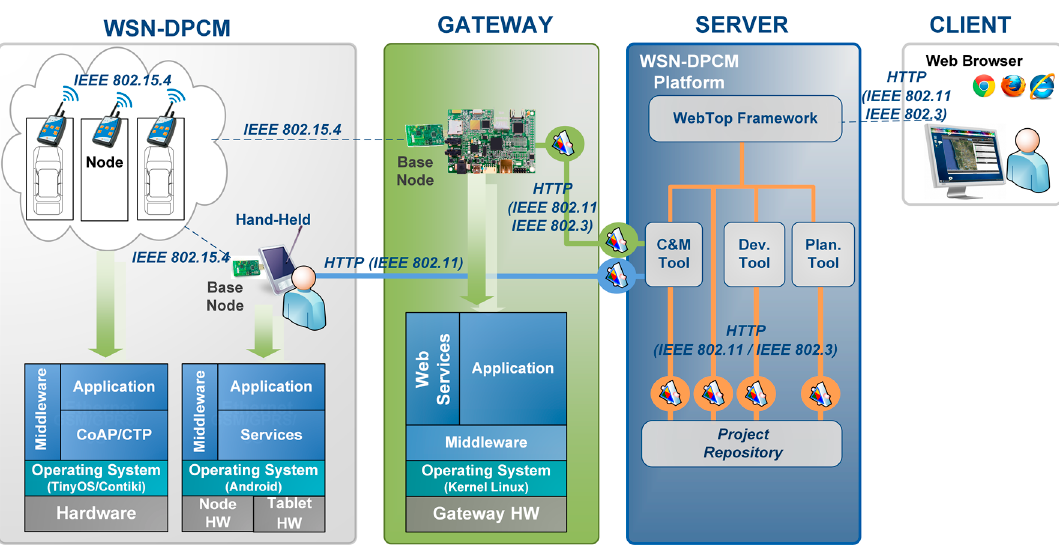
Figure 24. WSN infrastructure for the Smart parking demonstrator scenario.